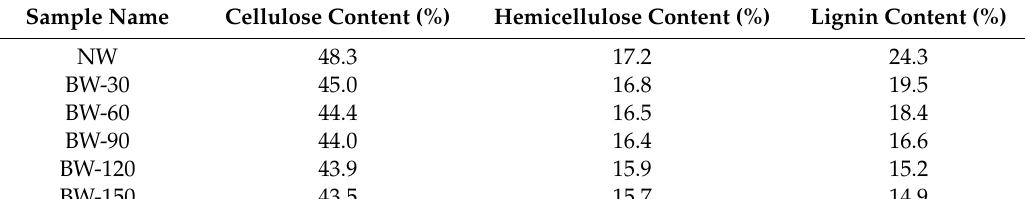
Table 1. Chemical composition content changes of various degrees of H 2 O 2 bleaching treatment.